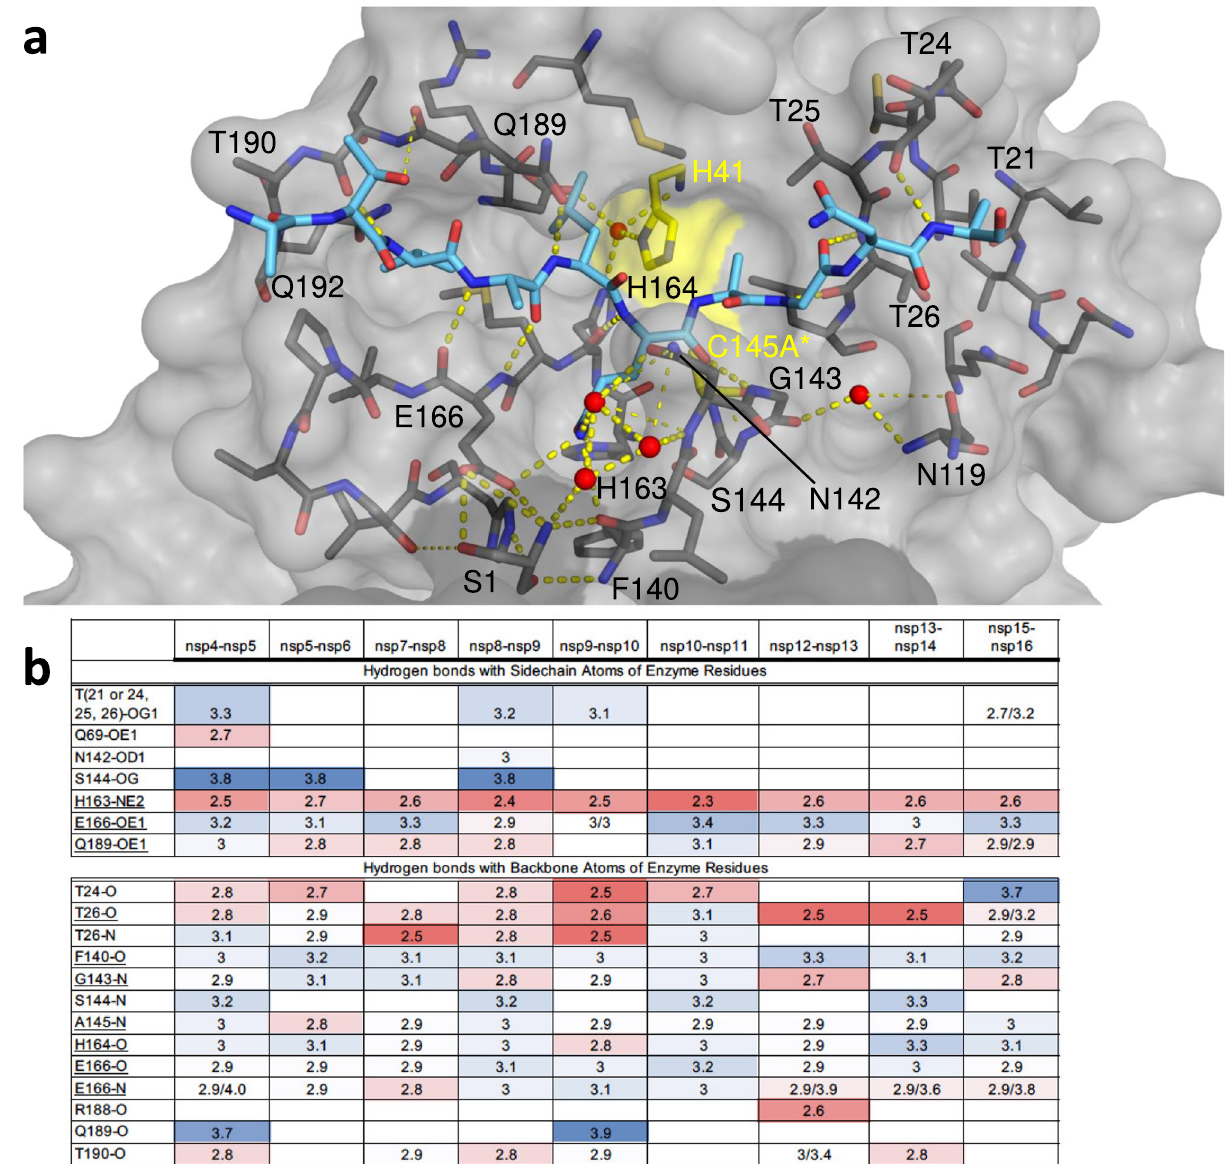
Fig. 2 Intermolecular hydrogen bonds in M pro substrate cocrystal structures. a Hydrogen bonds between bound nsp9-nsp10 substrate and M pro . The substrate peptide is depicted as cyan sticks and the protease is in gray surface representation with the catalytic dyad colored yellow. Yellow dashed lines indicate hydrogen bonds (thicker lines for stronger bonds with distance less than 3.5 Å) and red spheres denote conserved water molecules. Ser1 depicted as sticks belongs to the other monomer (shown in darker gray). b Hydrogen bonds that are conserved in three or more substrate complexes; underlined completely conserved, top interacting with M pro sidechains and bottom with M pro backbone atoms, color coded by the distance of the hydrogen